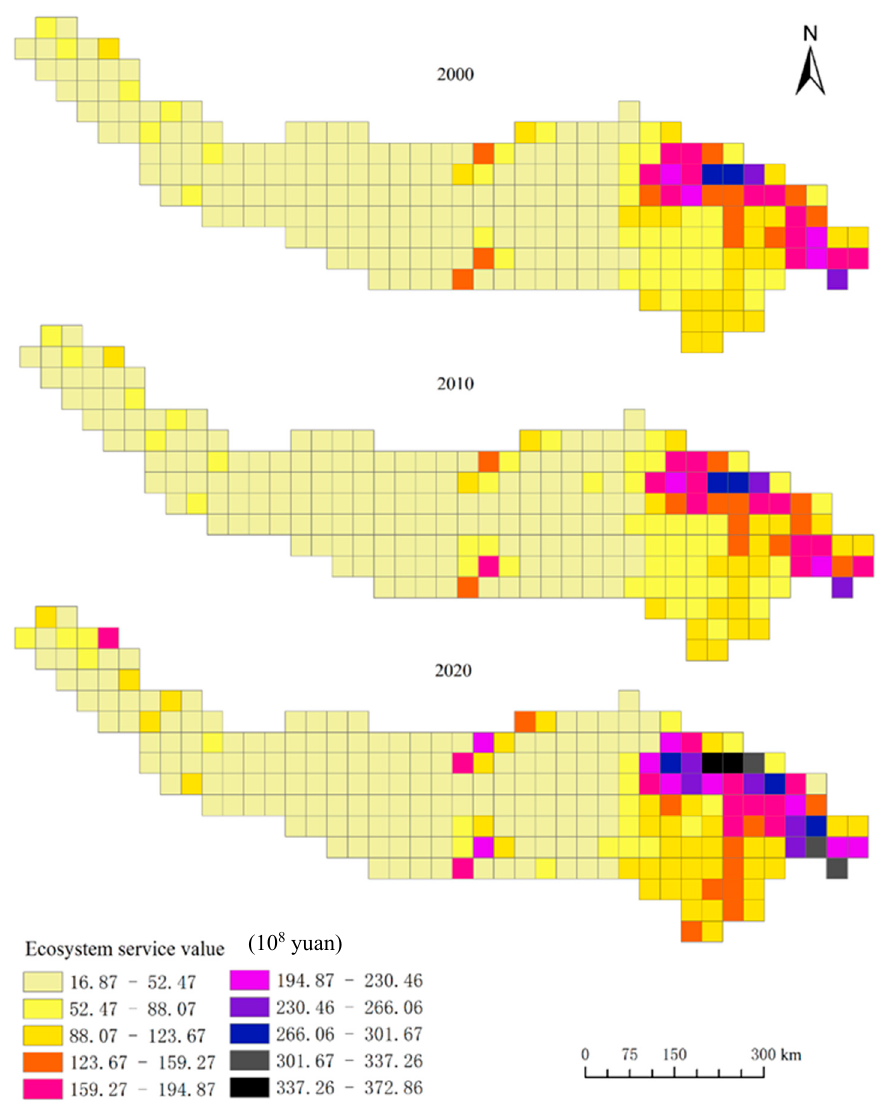
Figure 2 . Grid-based ecosystem services value in the Yarlung Zangbo river basin from 2000 to 2020.